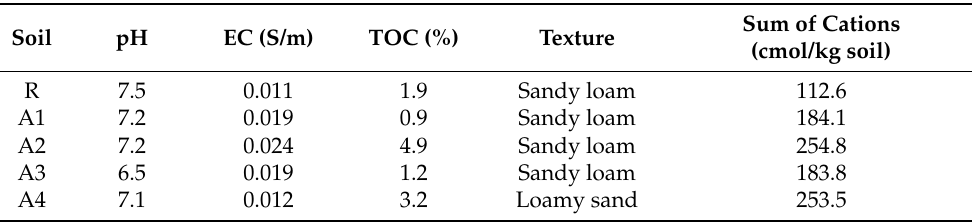
Table 1. Physicochemical characteristics of reference and test soils in North Chungcheong Province, Korea, used in soil ecological risk assessments.